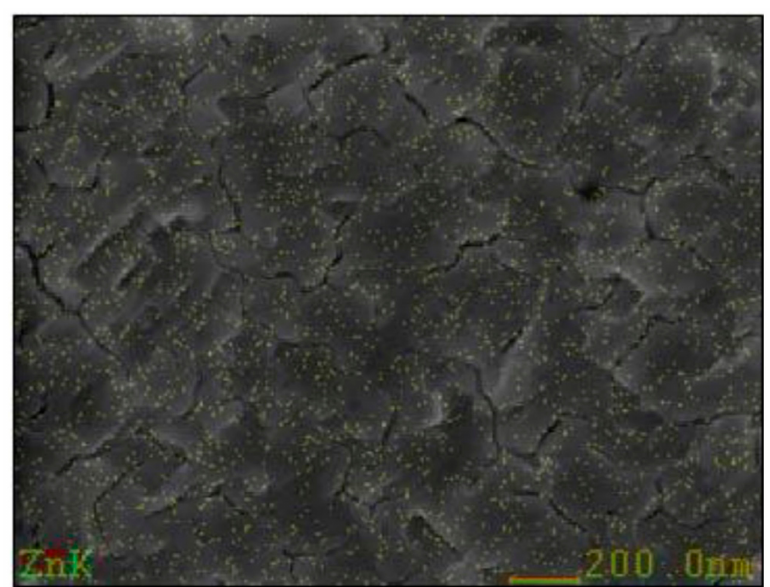
Figure 8. EDS Elemental mapping of Zn atoms in the perovskite lattice. The Zn atoms are evenly dispersed over the structure and not aggregated at grain boundaries. MA(Pb:Zn)I 3 -[Cl − ]. Reproduced from Sustain. Energy Fuels 2018 , 1093–1100, Reference [13], with permission from The Royal Society of Chemistry.